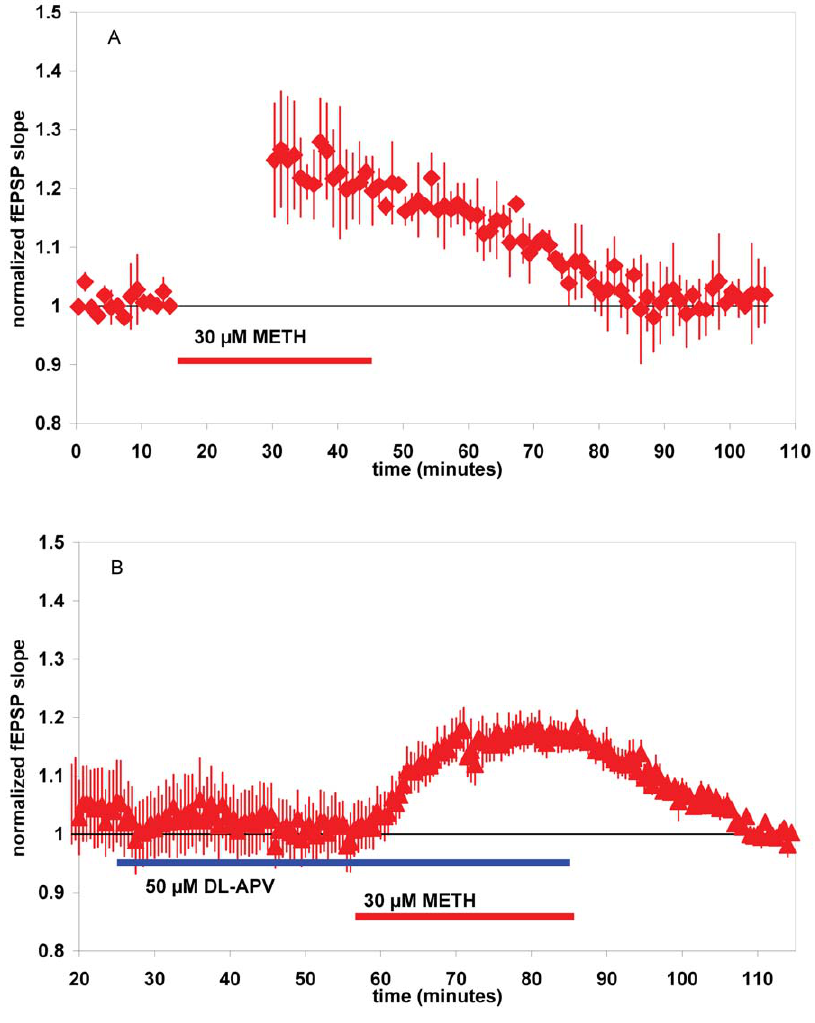
Figure 2. METH-induced increase in synaptic transmission does not require stimulation, and is transient- returning to baseline within and hour. Also, METH effects on baseline synaptic transmission are not dependent on NMDA receptors. ( A ) METH increase in synaptic transmission is not long-lasting, and does not require stimulation. Summary plot of normalized fEPSP slope measurements recorded in the CA1 region of the hippocampus. Results are from METH-treated slices. Stimulator turned off from t=15 to t=30. Error bars show 6 SEM. ( B ) The effects of METH on baseline synaptic transmission are not altered by blockade of NMDA receptors. Summary plot of normalized fEPSP slope measurements recorded in the CA1 region of the hippocampus. Result are from DL-APV + METH-treated slices. Error bars show 6